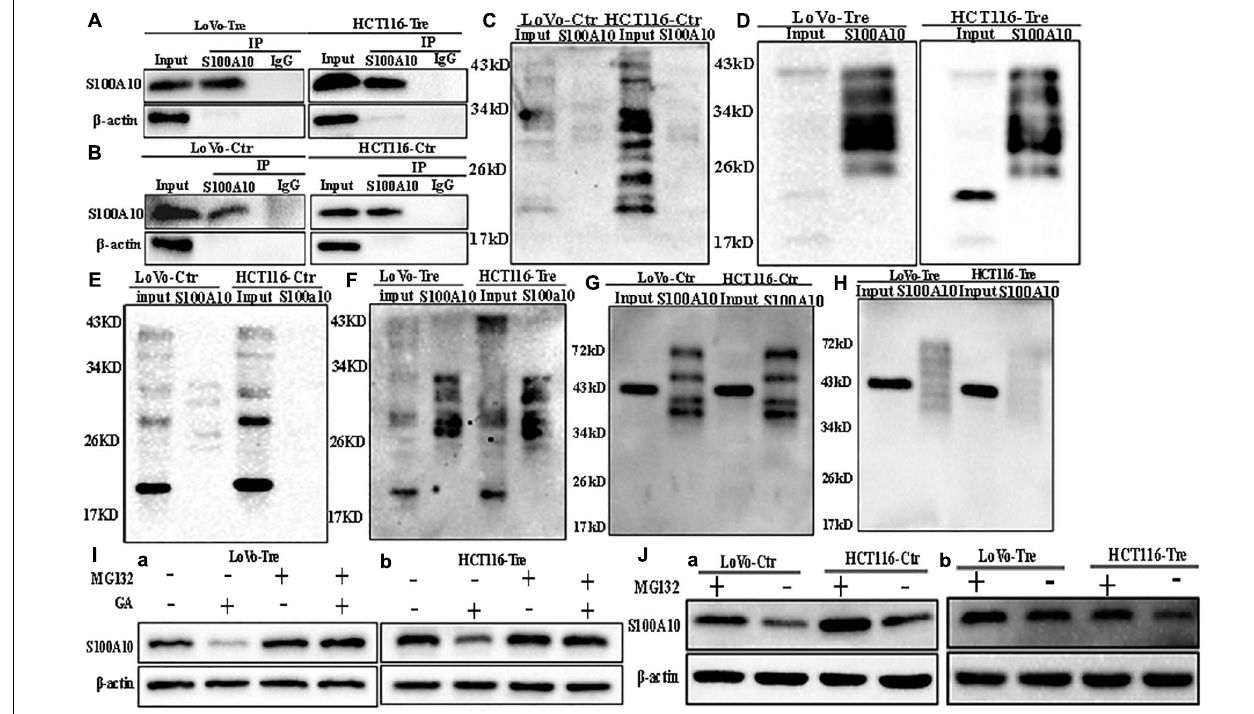
FIGURE 2 | SUMOylation and ubiquitination of S100A10 in LoVo and HCT116 cells before and after CoCl 2 treatment. (A) Results of S100A10 co-immunoprecipitation in LoVo and HCT116 PGCCs with daughter cells (anti-S100A10 was used to perform immunoprecipitation). (B) Results of S100A10 co-immunoprecipitation in LoVo and HCT116 control cells (anti-S100A10 was used to perform immunoprecipitation). (C) Total lysates of LoVo and HCT116 control cells were immunoprecipitated with anti-S100A10 and immunoblotted with anti-SUMO1. (D) Total lysates of LoVo and HCT116 PGCCs with daughter cells were immunoprecipitated with anti-S100A10 and immunoblotted with anti-SUMO1. (E) Total lysates of LoVo and HCT116 control cells were immunoprecipitated with anti-S100A10 and immunoblotted with anti-SUMO2/3. (F) Total lysates of LoVo and HCT116 PGCCs with daughter cells were immunoprecipitated with anti-S100A10 and immunoblotted with anti-SUMO2/3. (G) Total lysates of LoVo and HCT116 control cells were immunoprecipitated with anti-S100A10 and immunoblotted with anti-Ubiquitin (linkage-specific K48). (H) Total lysates of LoVo and HCT116 PGCCs with daughter cells were immunoprecipitated with anti-S100A10 and immunoblotted with anti-Ubiquitin (linkage-specific K48). (I) (a) S100A10 expression in LoVo PGCCs and daughter cells with and without GA, MG132, and both GA and MG132 treatment. (b) S100A10 expression in HCT116 PGCCs and daughter cells with and without GA treatment, MG132 treatment and the treatment of both GA and MG132, respectively. (J) (a) S100A10 expression in LoVo and HCT116 control cells before and after the MG132 treatment. (b) S100A10 expression in LoVo and HCT116 PGCCs with their daughter cells before and after the MG132 treatment. Ctr: control cells; Tre: cells treated with CoCl 2